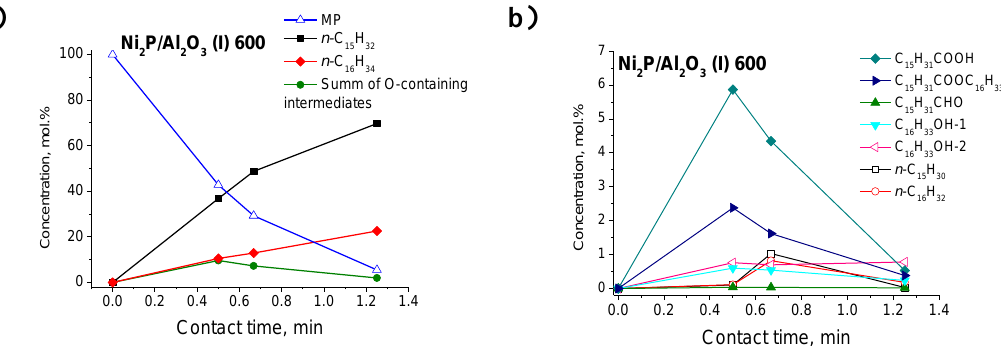
Figure 13. Concentration profiles of the liquid-phase components during methyl palmitate HDO over NiP_I/Al 2 O 3 (600) catalyst: ( a ) MP, C 15 and C 16 hydrocarbons and sum of oxygen-containing intermediates; ( b ) the observed intermediates (P H2 = 3.0 MPa, T = 290 °C, H 2 /feed = 600 Nm 3 /m 3 , contact time = 0.50–1.25 min).